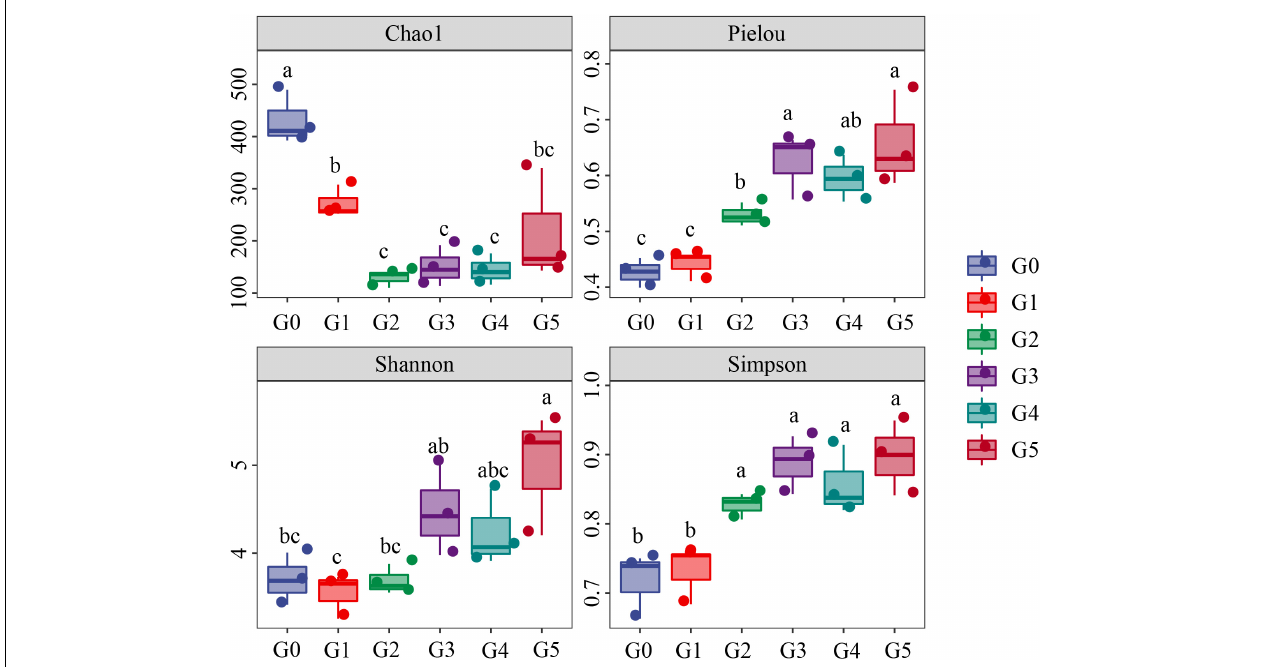
FIGURE 2 | Chao1 index, Pielou index, Shannon index and Simpson index were first examined by ANOVA ( p < 0.05) and then analyzed using Fisher’s LSD test at the p < 0.05 level. Means with different letters indicate significant differences at the p < 0.05 level according to Fisher’s LSD test.